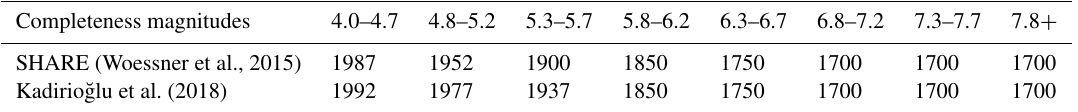
Table 2. Completeness time as a function of magnitudes used in this